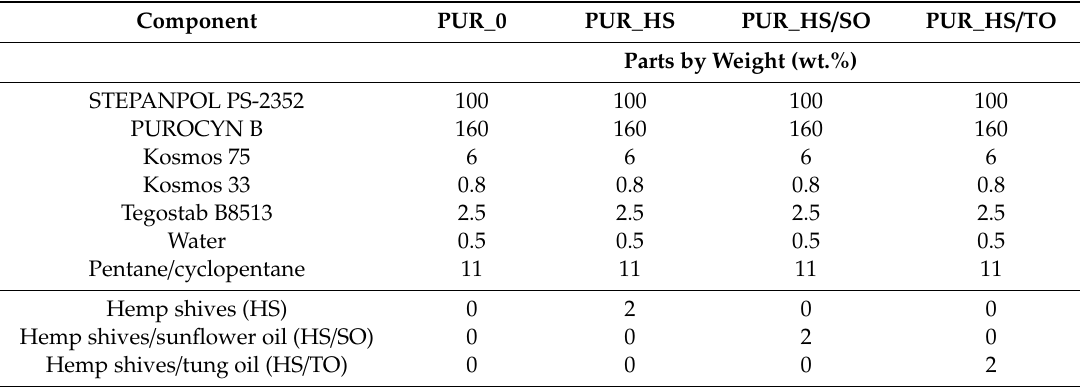
Table 2. Composition of PUR composite